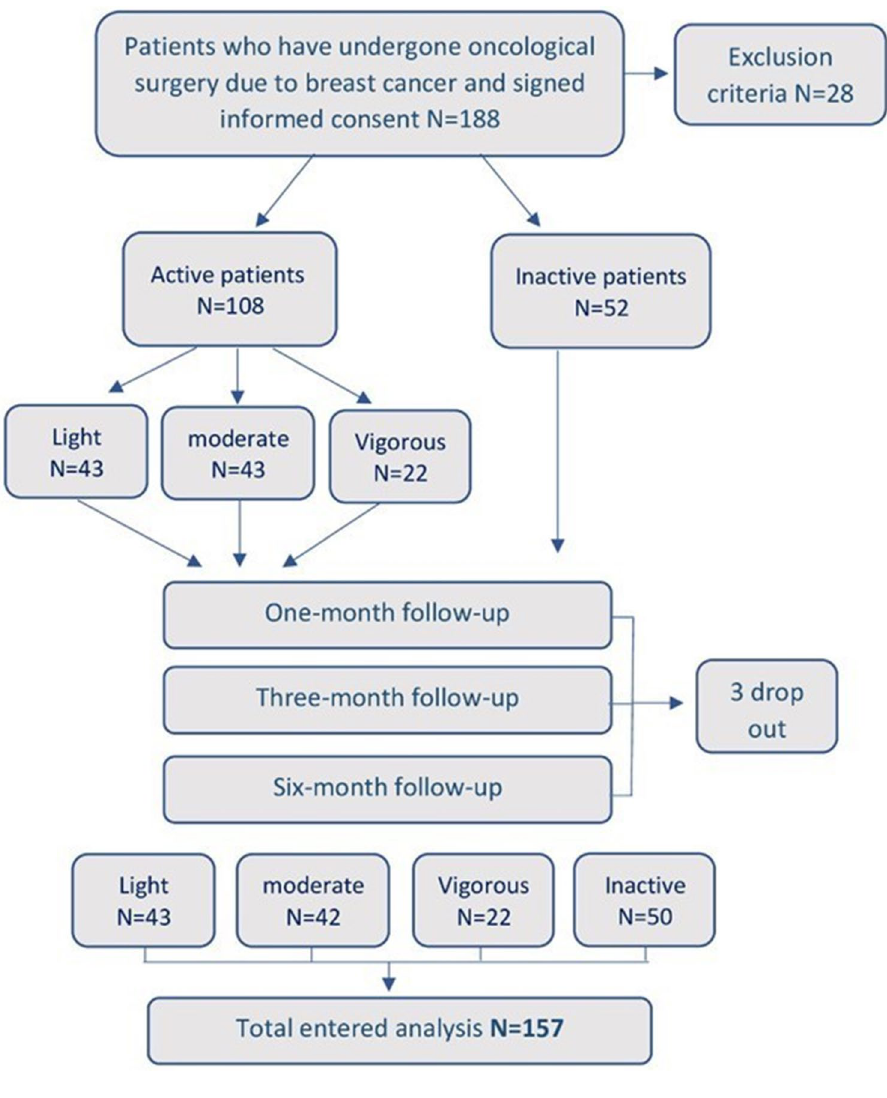
Figure 1. Study flow